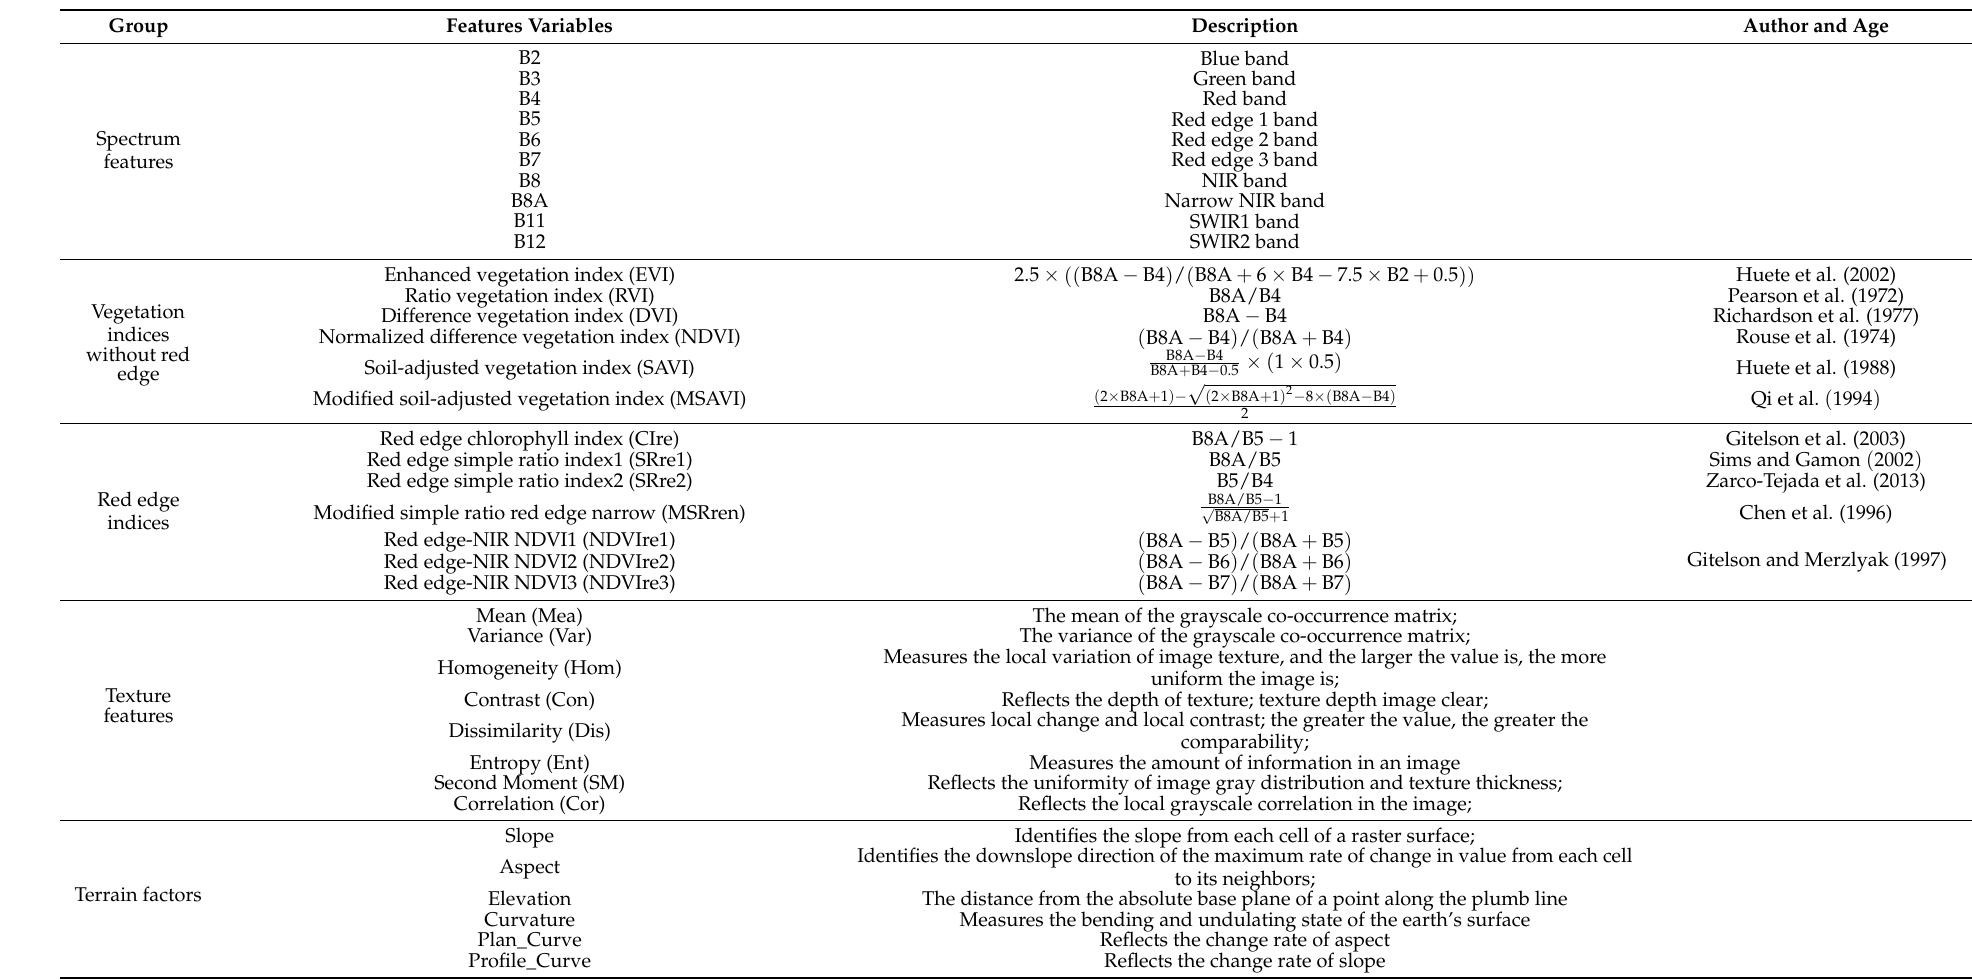
Table 3. Descriptions of the different feature